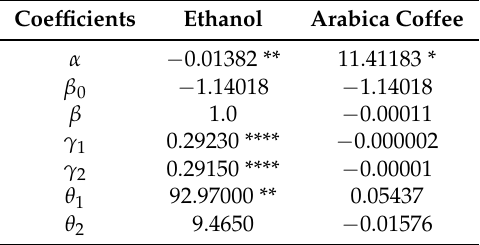
Table 5. The VECM for the ETH-ARA pair in P 3 . Significance levels: 10% (*), 5% (**), 1% (***) and 0.1% (****).